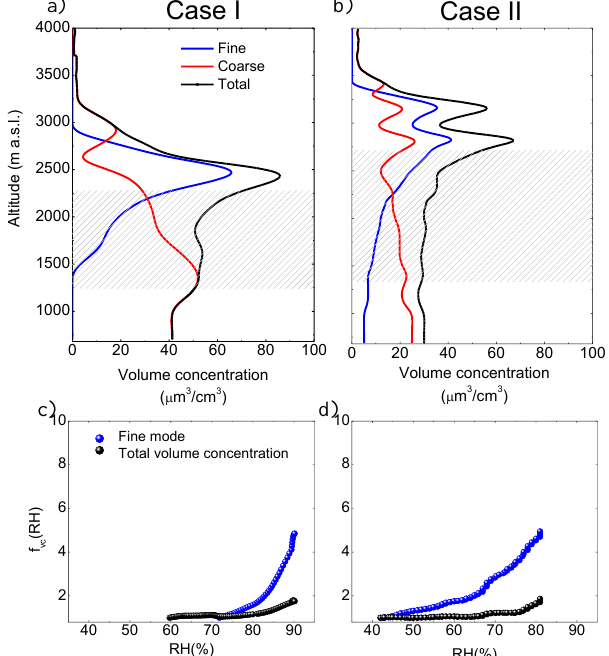
Figure 6. (a) LIRIC retrieved volume concentration (fine mode, coarse mode and total concentration) profiles on 22 July 2011 from 20:30 to 21:00UTC. The shaded area indicates the height range where hygroscopic growth was investigated. (b) LIRIC re- trieved volume concentration profiles on 22 July 2013 from 20:00 to 20:30UTC. The shaded area indicates the investigated height range. (c) f VC (RH) versus RH for the fine mode and the total volume con- centrations for 22 July 2011 and the layer corresponding to heights between 1330 and 2330ma.s.l. (d) f VC (RH) vs. RH for the fine mode and the total volume concentrations for 22 July 2013 and the layer corresponding to heights between 1300 and